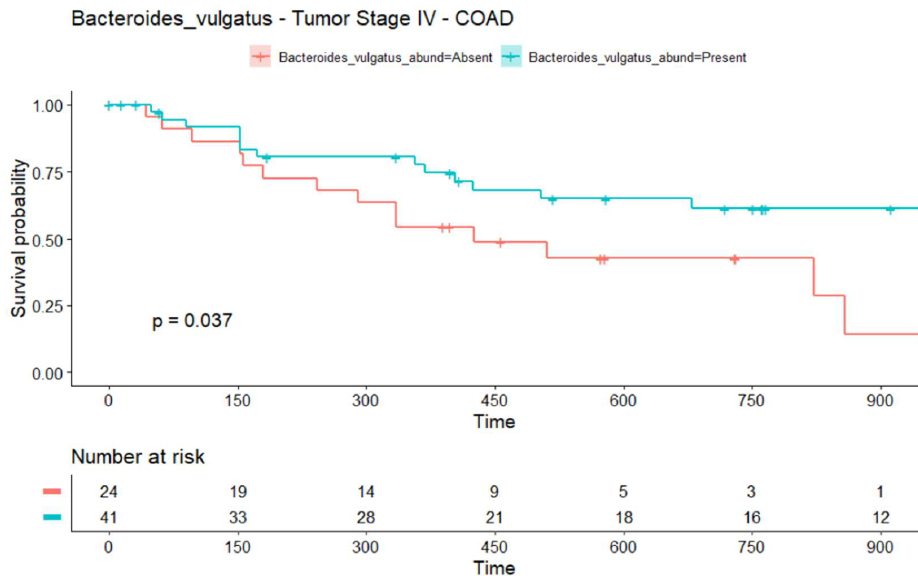
Figure 4. Bacteroides vulgatus in COAD tissues is associated with a better survival. OS curves and risk table for Bacteroides vulgatus in two conditions—absent (red) and present (blue)—for stage IV colon adenocarcinoma patients. Time is in days.